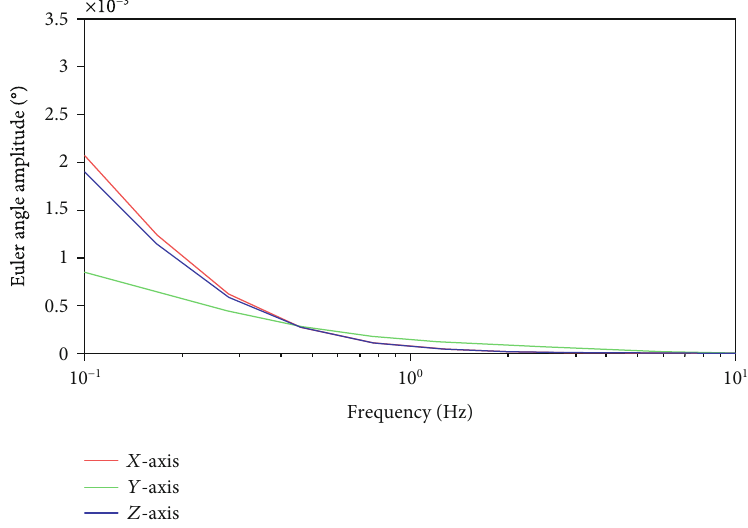
Figure 13: Magnitude-frequency characteristic of the PID controller.